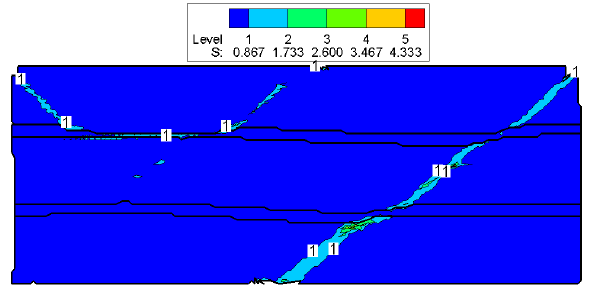
Fig. 2. The isometrics of the effective plastic strain in the center axial section to the time moment of 3000 ms.